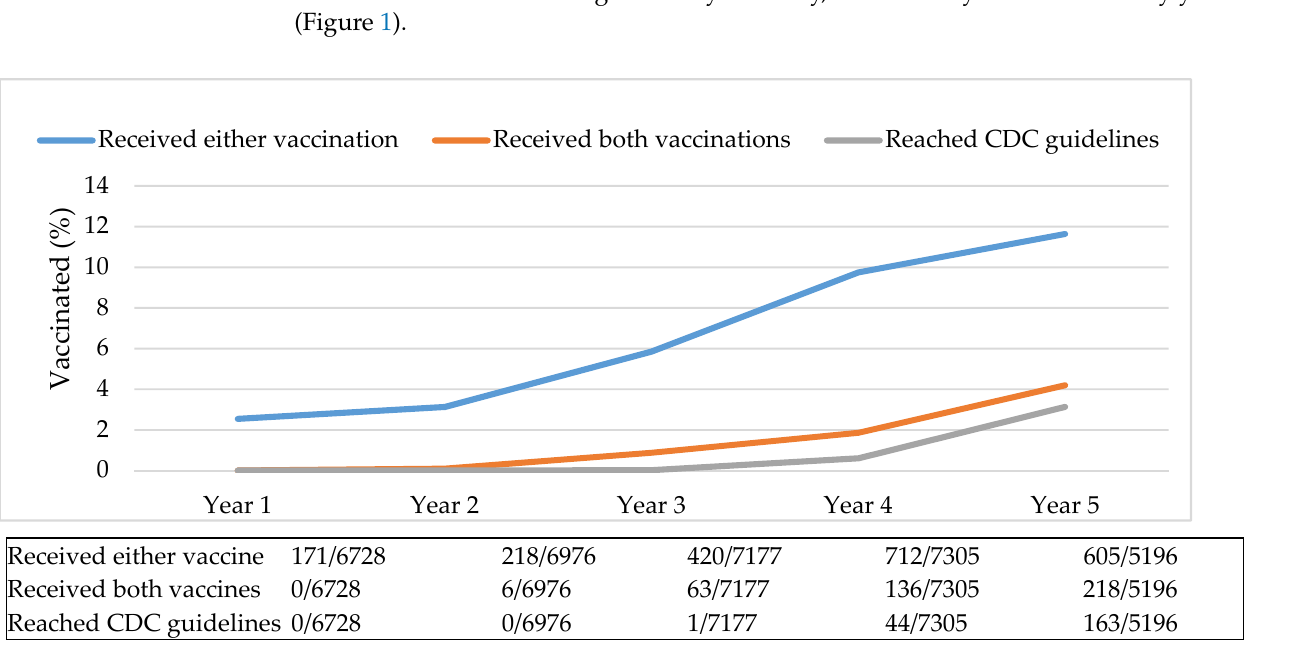
Figure 1. Annual vaccination rates. Abbreviations used: CDC: Centers for Disease Control and Prevention.